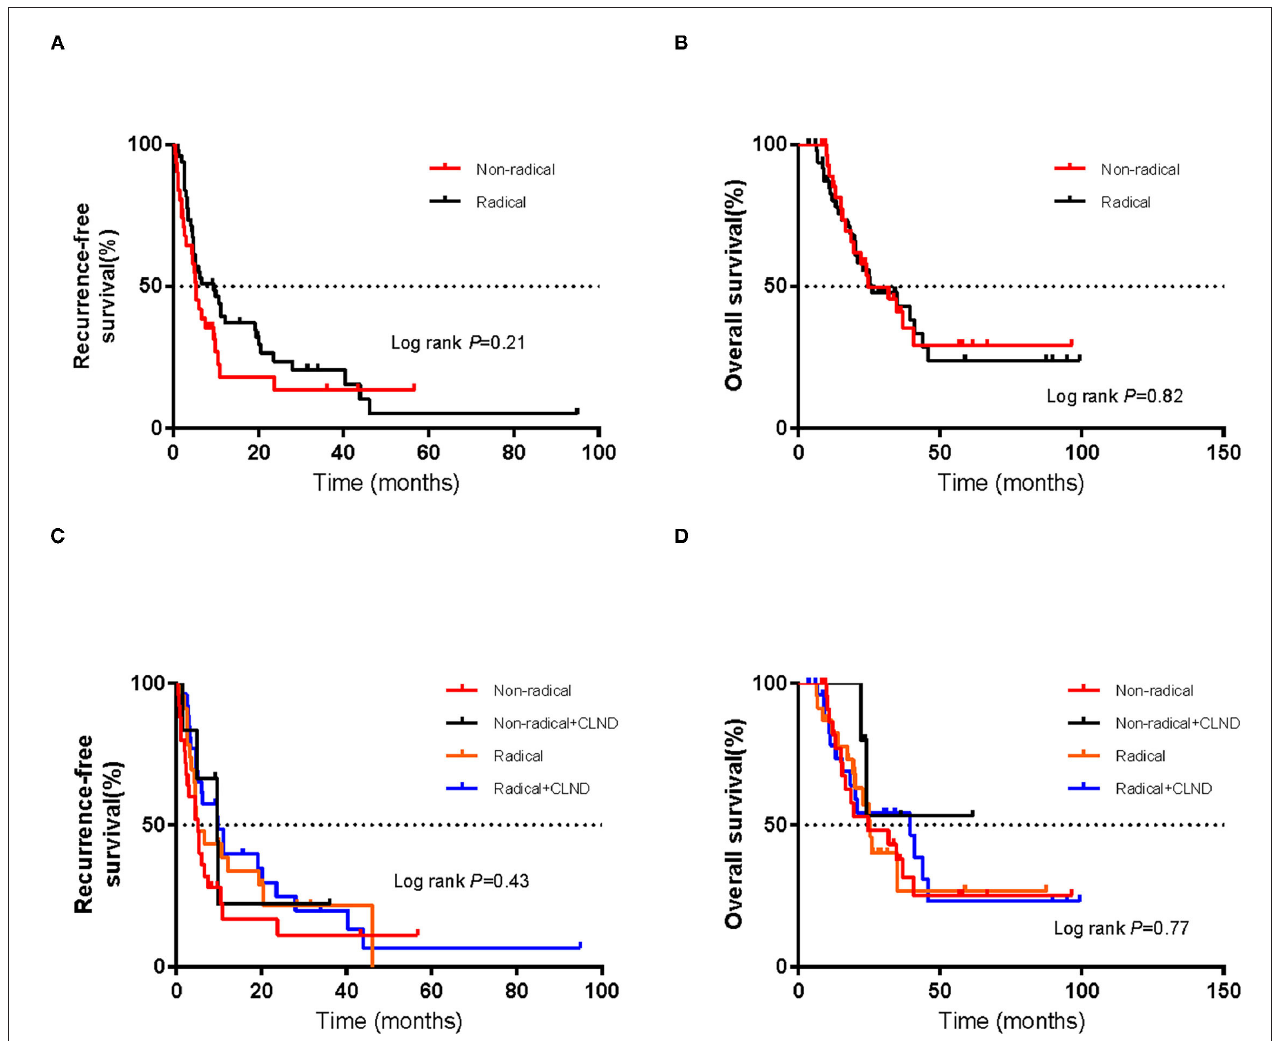
FIGURE 1 | Kaplan–Meier curves of (A) recurrence-free survival and (B) overall survival in the non-radical resection and radical resection groups. Kaplan–Meier curves of (C) recurrence-free survival and (D) overall survival of patients who did or did not undergo complete lymph node dissection (CLND) in each of the non-radical resection and radical resection groups. The log-rank test was used to evaluate differences between